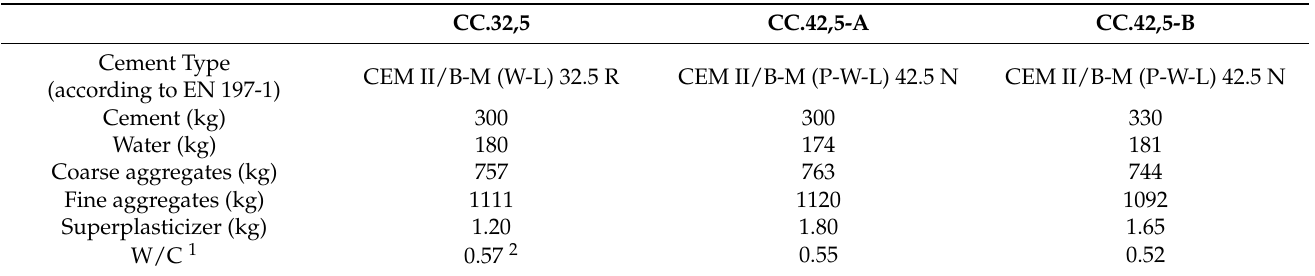
Table 3. Composition of CC mix (per 1 m 3 of concrete).